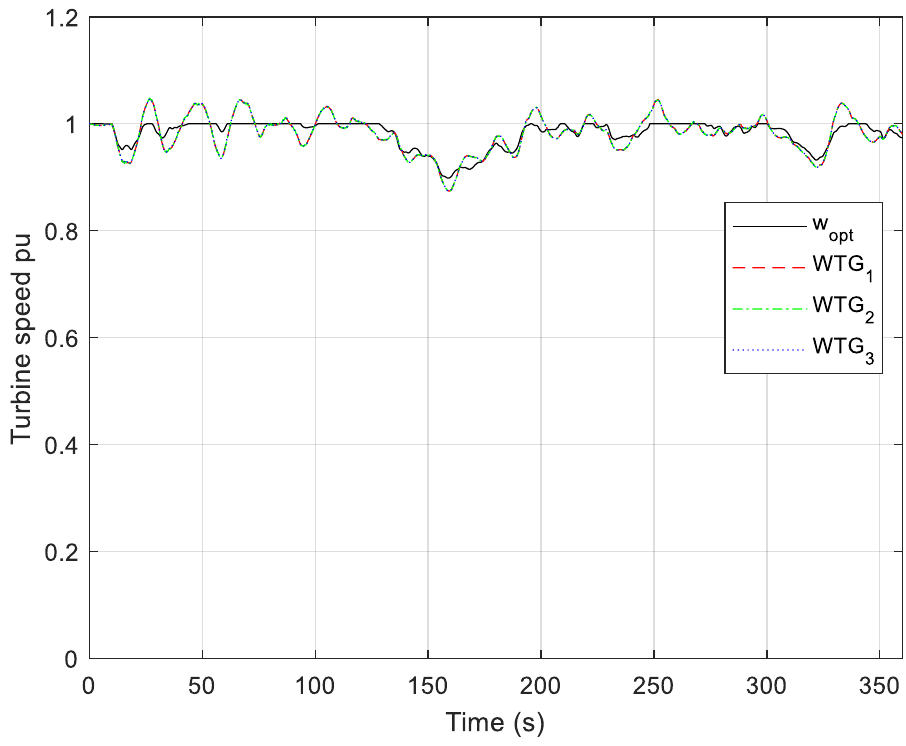
Figure 23. Reference (optimal) speed and speeds of WTGs (random wind disturbance).